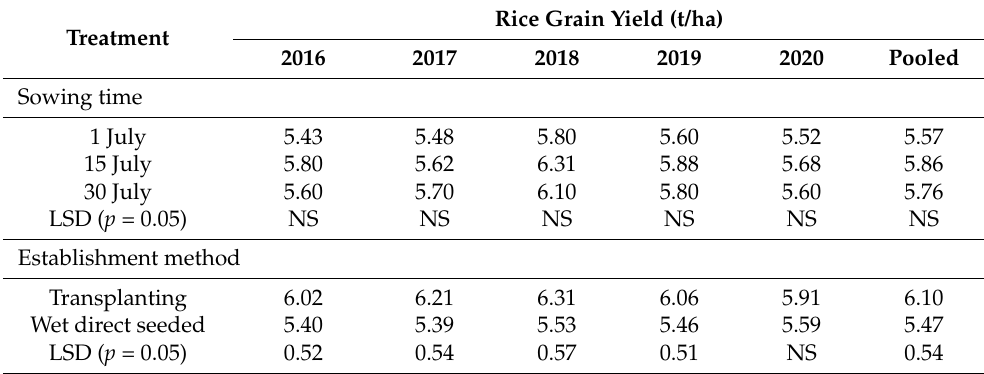
Table 2. Rice grain yield under conservation agriculture over the